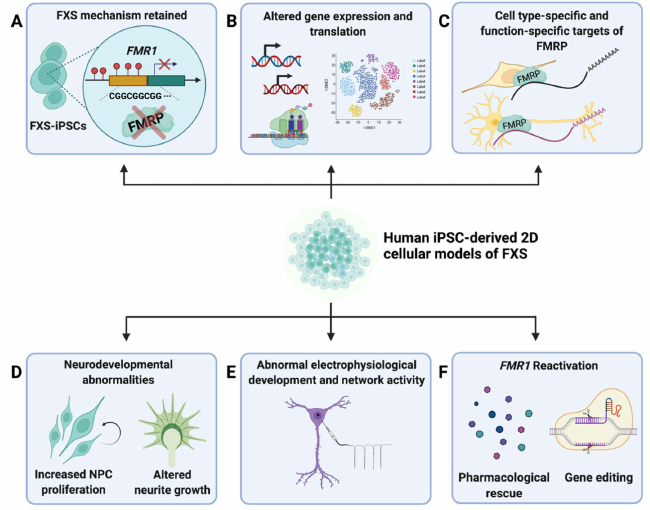
Figure 1. Summary of major findings from 2D FXS−iPSC−derived models. ( A ) Studies that have utilized 2D hiPSC-derived models of FXS have found that the fundamental molecular mechanisms of FXS pathology is retained in iPSCs derived from primary cells of FXS patients (FXS-iPSCs) [46,47]. ( B ) FXS-iPSCs and derived neural cells showed altered gene expression and translation